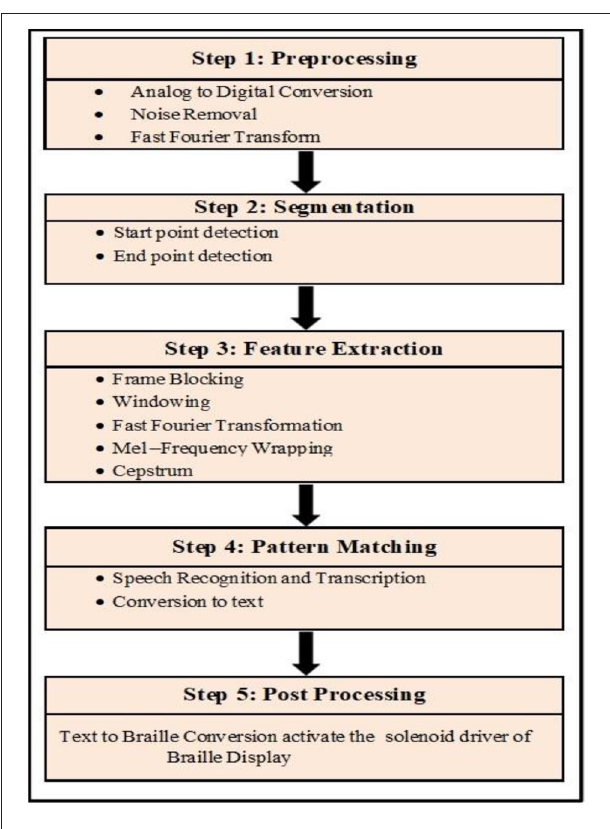
FIGURE 3 | Flow of Proposed Methodology.